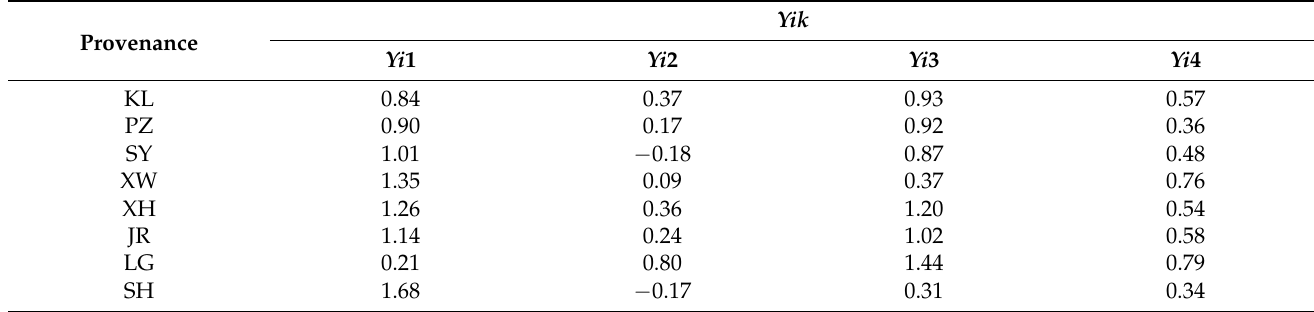
Table A3. The value of the comprehensive indexes of the different provenances under mild drought stress.